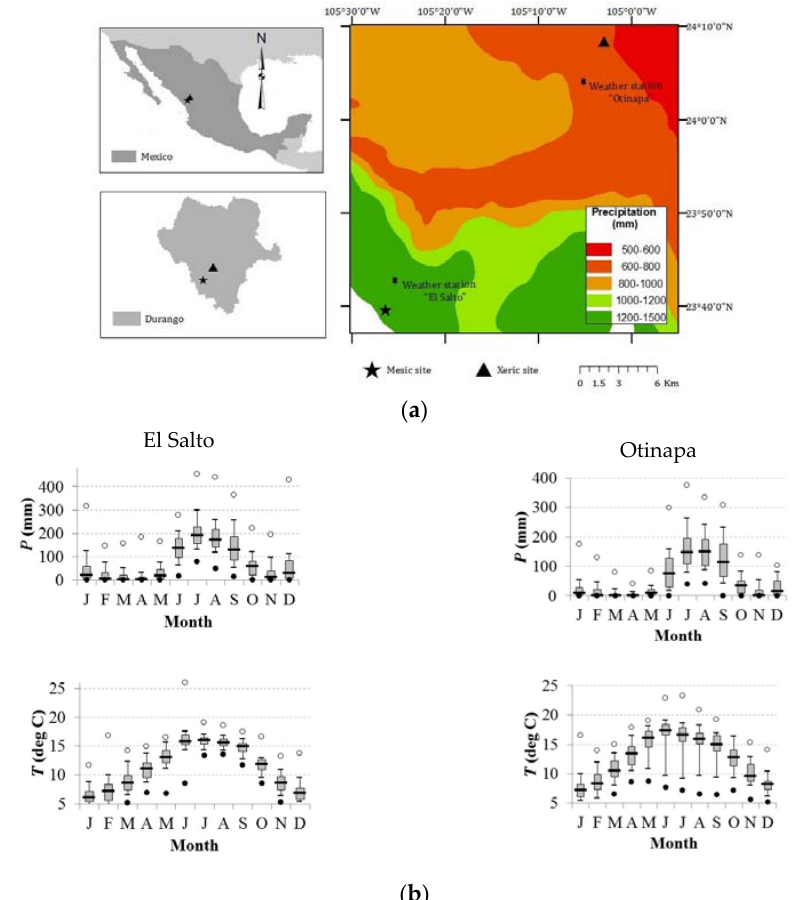
Figure 1. ( a ) Site locations in northern México and the Durango state; and ( b ) climate diagrams of the El Salto and Otinapa stations corresponding to the mesic and xeric habitats, respectively. The map shows the study area, where trees of A. durangensis , C. lusitanica , from the mesic site (star), and P. engelmannii and P. cembroides from the xeric site (triangle) were sampled. The diagrams show the distribution (box plots) of monthly precipitation ( P ) and temperature ( T ) data. Months are abbreviated by J = January, F = February, …, D = December.